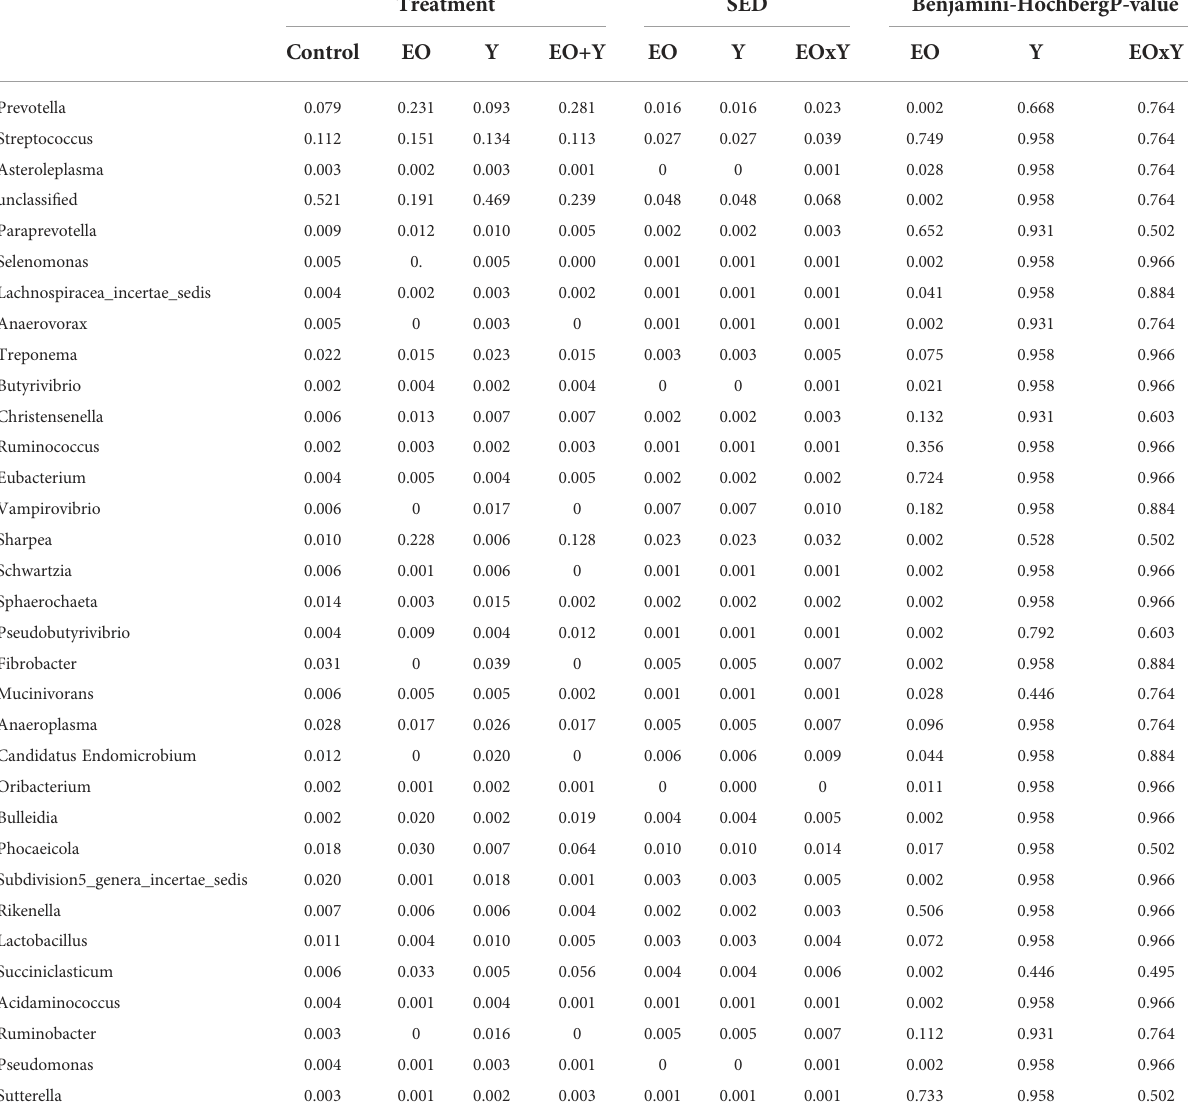
TABLE 7 Effect of supplementing a control diet (C) with oregano oil (EO), yeast (Y) or a combination of both (EO+Y) on the relative abundance of bacteria genera present at an average of more than 0.2% (false discovery rate for Benjamini-Hochberg:0.25). Treatment